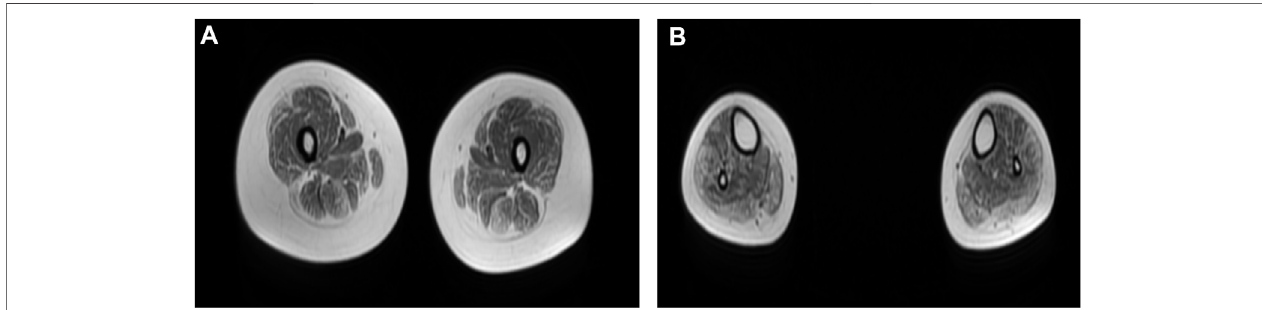
FIGURE 1 | (A,B) Muscle MRI of lower limbs showed fatty in fi ltration and muscle atrophy of proximal and distal lower limb muscles, with the most prominent involvementinposterior muscles. (A) Thighlevel.The biceps femoris(long head),semitendinosus,vastuslateralis,gracilis, and sartorius muscleare mildly tomoderately affected. The rectus femoris is the best spared muscle. (B) Calf level. The gastrocnemius (medial head and lateral head), peroneus ( fi bularis) brevis, and peroneus ( fi bularis) longus muscle are moderately affected.